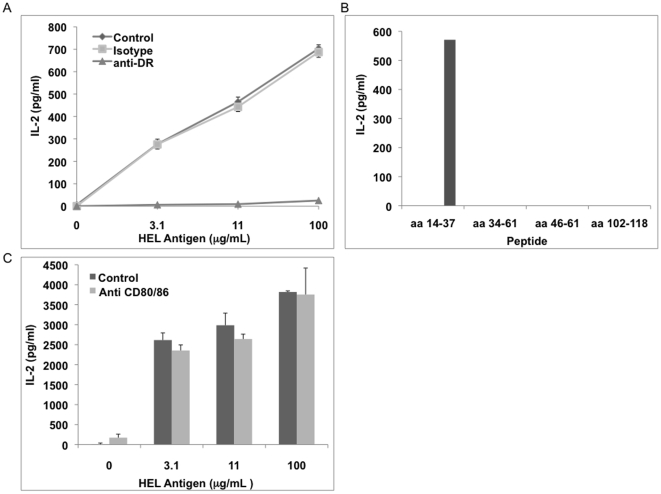
Characterization of T cell hybridoma clone 15HEL.MN (5×104/well) were incubated with antigen (intact HEL for A and C, HEL peptides for B) and 15HEL (1×105/well) for 24 hrs. Supernatants were harvested, and IL-2 measured by ELISA. A. Effect of anti-HLA-DR or isotype on response. B. Identification of HEL peptide epitope recognized by 15HEL. C. Effect of anti-CD80 and CD86 antibodies together (5 µg/ml of each) or isotype control (10 µg/ml) on responses. Results of A and C represent triplicate wells and error bars SEM.